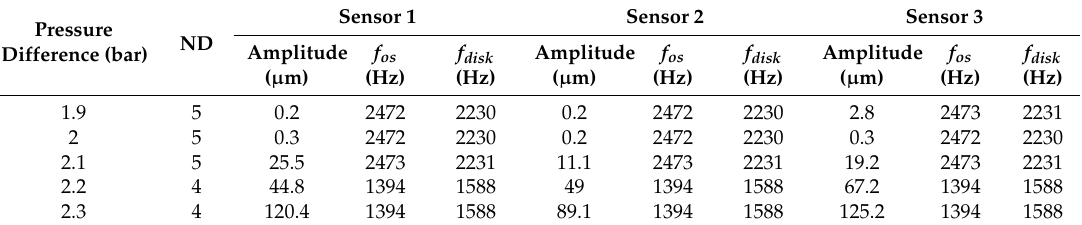
Table 5. Results for the first prototype at 2 × RPM nominal